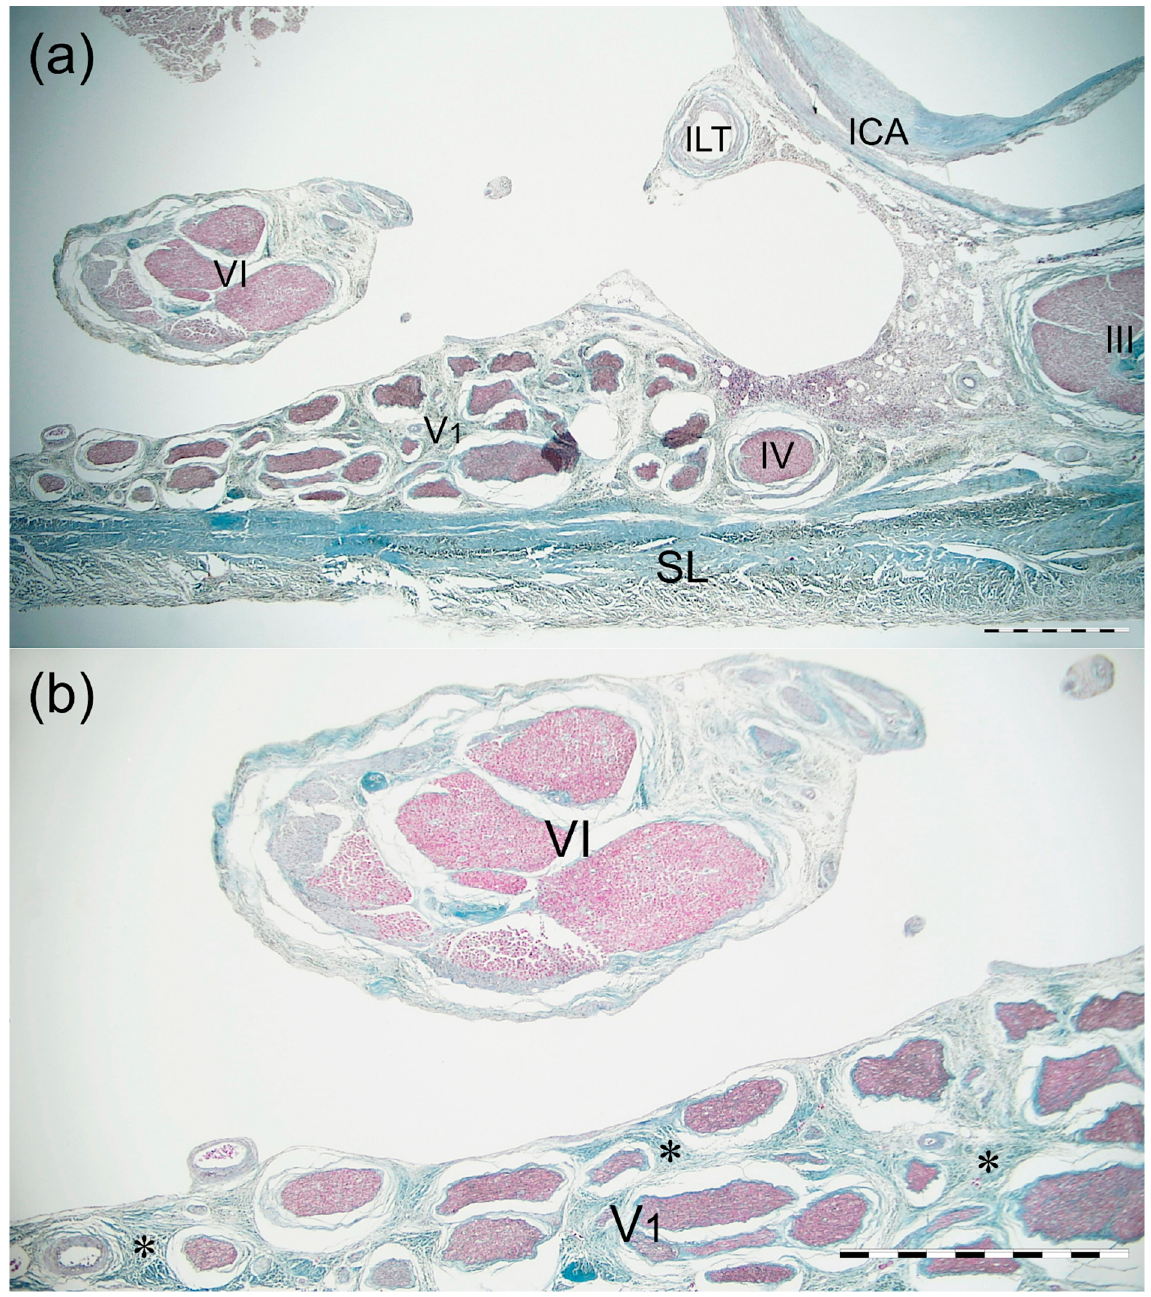
Figure 4. Cross-section of the AN, lateral wall of the CS, and the horizontal portion of the cavernous part of the ICA. Mallory’s trichrome stain. ( a ) Panoramic view of the specimen seen under 2 × objective lens. The AN (VI) runs on the medial side of the lateral wall of the CS, at the level of the trigeminal nerve’s ophthalmic division (V1). ICA—internal carotid artery; ILT—branch of the inferolateral trunk; SL—superficial layer of the lateral wall of the CS; III—oculomotor nerve; IV—trochlear nerve. ( b ) Magnification of the specimen seen in figure ( a ). 4 × objective lens. The single trunk of the AN (VI) contains a few fascicles surrounded by common epineurium composed of dense irregular connective tissue. Collagen fibers surround the fascicles of the trigeminal nerve’s ophthalmic division (V1), forming the deep layer (reticular membrane) of the lateral wall of the CS. Scale bar corresponds to 1 mm.